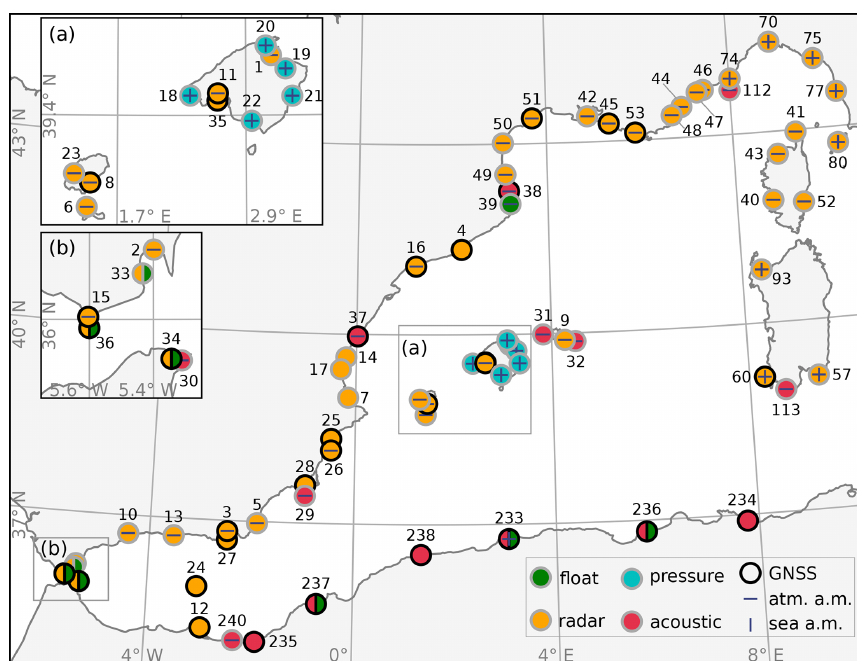
Figure 4. Active tide gauge stations in the western Mediterranean Sea. Marker colour indicates tide gauge sensor, while black circle indicates collocation with GNSS station. Ancillary measurements, atmospheric or oceanographic, are indicated by navy blue horizontal and vertical dashes, respectively. Station names are listed in the Appendix tables: Tables A1–A9 and A26–A27. Stations 26, 27, 29, 32, 34, 35, 36, and 112 are slightly shifted to ensure better